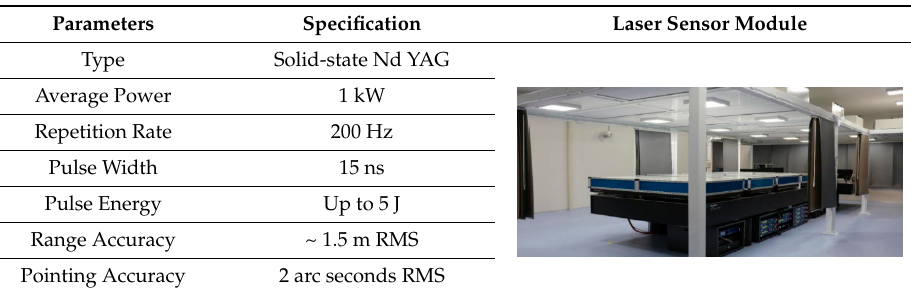
Table 2. The laser tracking sensor specification [15].